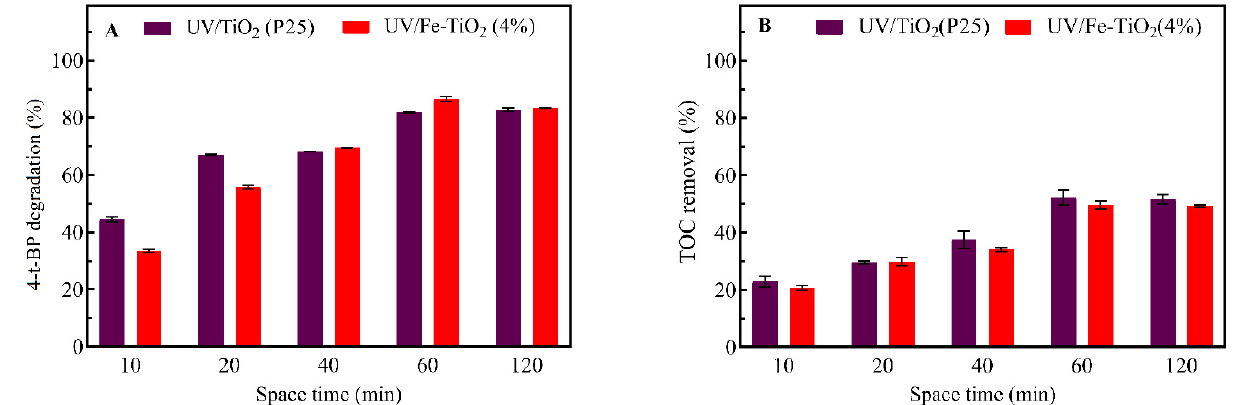
Figure 5. 4-t-BP degradation ( A ) and TOC removal ( B ) as a function of space time in the UV/TiO 2 and UV/Fe-TiO 2 .